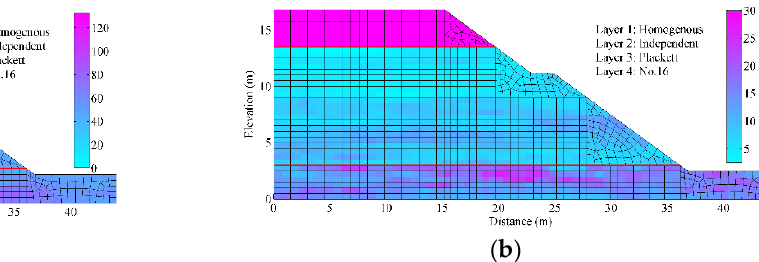
Figure 19. A typical realization of transversely anisotropic CCRF yielded by strategy 3. ( a ) Random field of c. ( b ) Random field of ϕ.